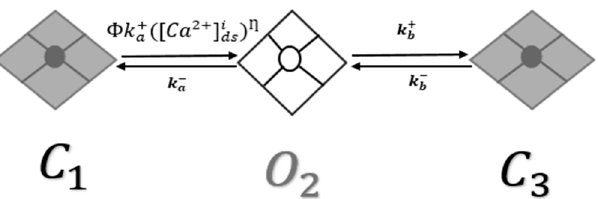
Figure 1. Opening probability (P o ) of RyR2 channels from closed state (C 1 ) to open state (O 2 ), is controlled by luminal regulation function ( Φ ) in the RyR2 model.